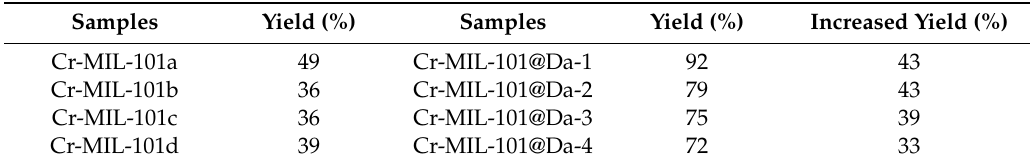
Table 1. Comparison of the yields of Cr-MOF and Cr-MOF@Da Samples Yield (%) Samples Yield (%) Increased Yield